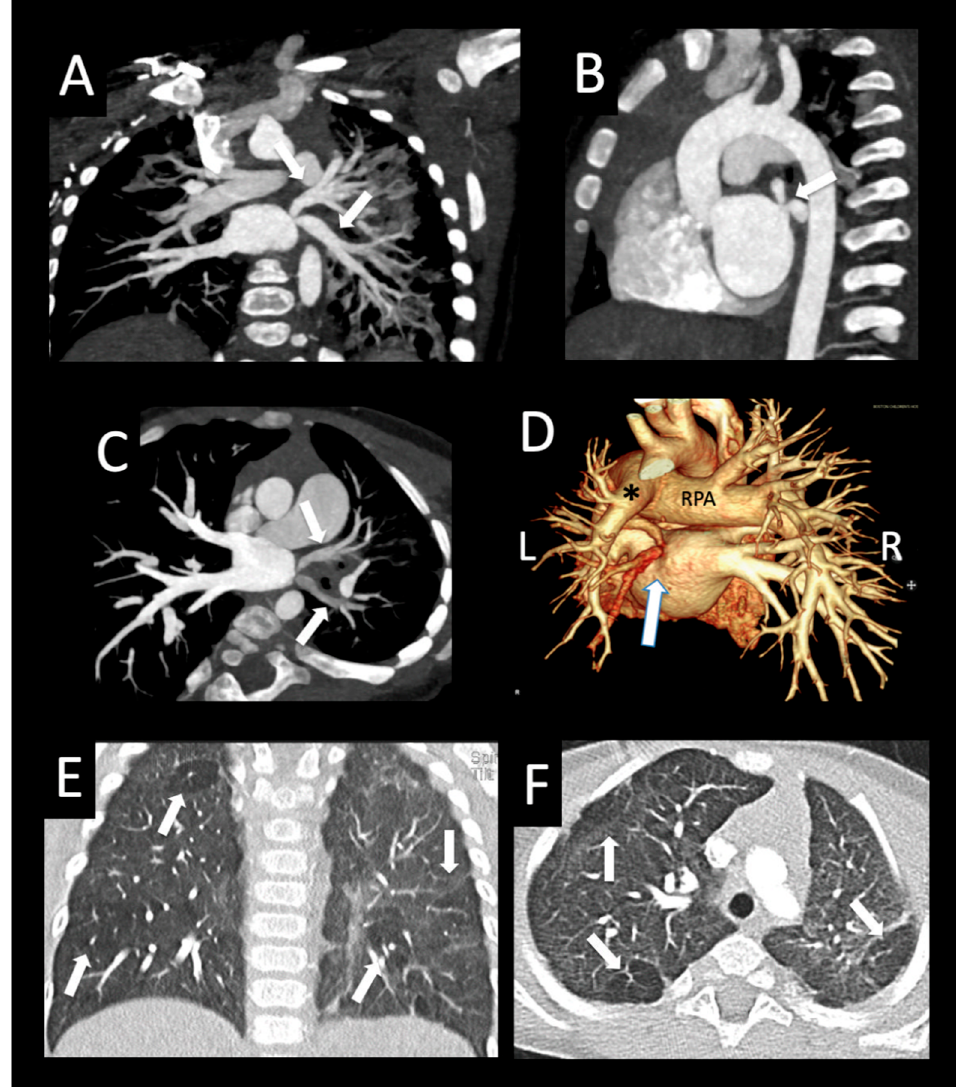
Figure 6. Oblique pulmonary vein course. Former premature infant with left-sided pulmonary vein stenosis and chronic lung disease. Coronal oblique ( A ) and sagittal ( B ) images show oblique, moderately narrowed orifices of the left upper pulmonary vein and left lower pulmonary vein to the superior aspect of the left atrium (arrows). Worsening focal ostial stenosis 4 months later, with decreased enhancement of both left upper pulmonary vein and left lower pulmonary vein (arrows ( C )) compared to the normal right pulmonary veins. Posterior volume rendered image ( D ) shows a small left pulmonary artery (*) and a large right pulmonary artery (RPA), in addition to the oblique insertion of the left pulmonary veins (arrow). Coronal and axial lung images ( E , F ) show bilateral mosaic attenuation of both lungs with hyperlucent lobules (arrows), consistent with alveolar enlargement and simplification associated with chronic lung disease of prematurity.